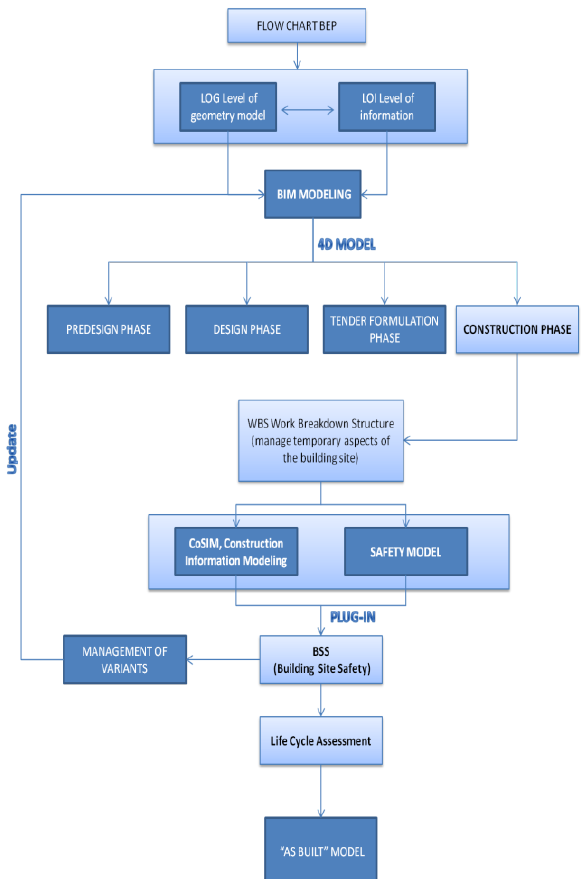
Figure 1. The Methodology scheme